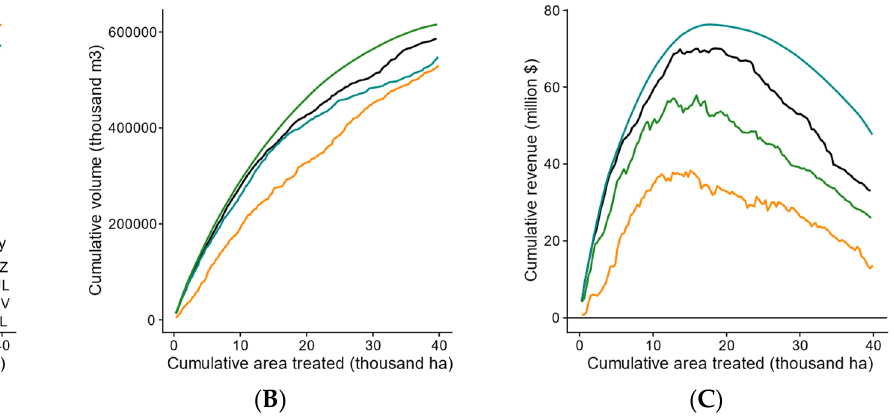
Figure 5. Treatment prescriptions within projects with 300 ha of treated area scheduled for four scenarios: max net revenue, max volume, max hazard, and multi-objective.